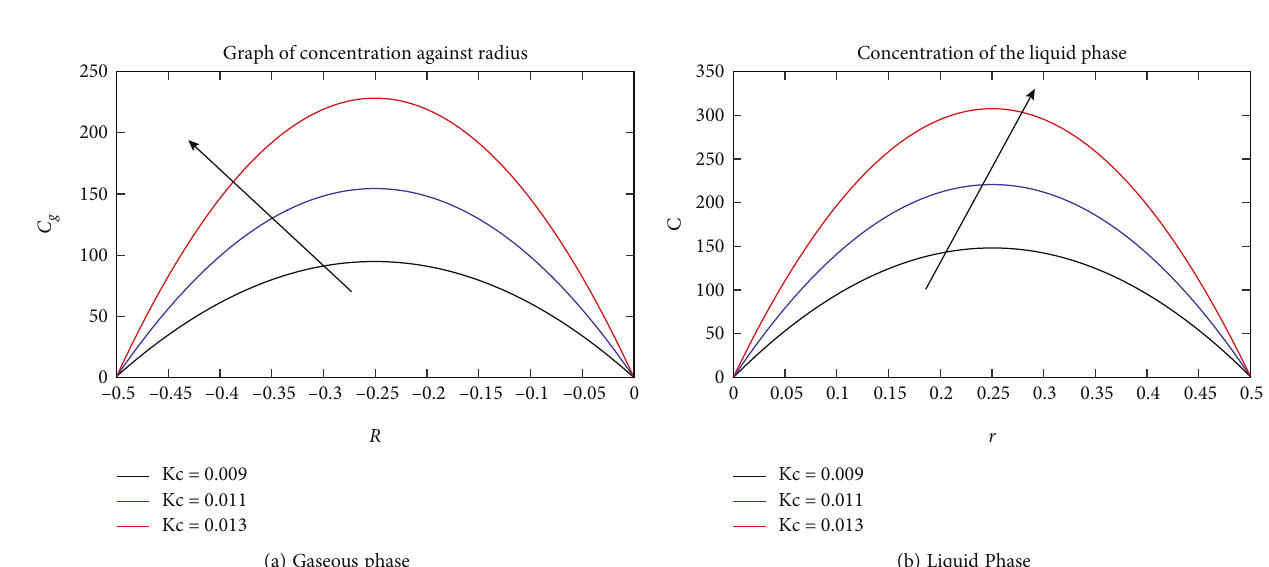
Figure 11: E ff ect of Chemical Reaction Parameter on